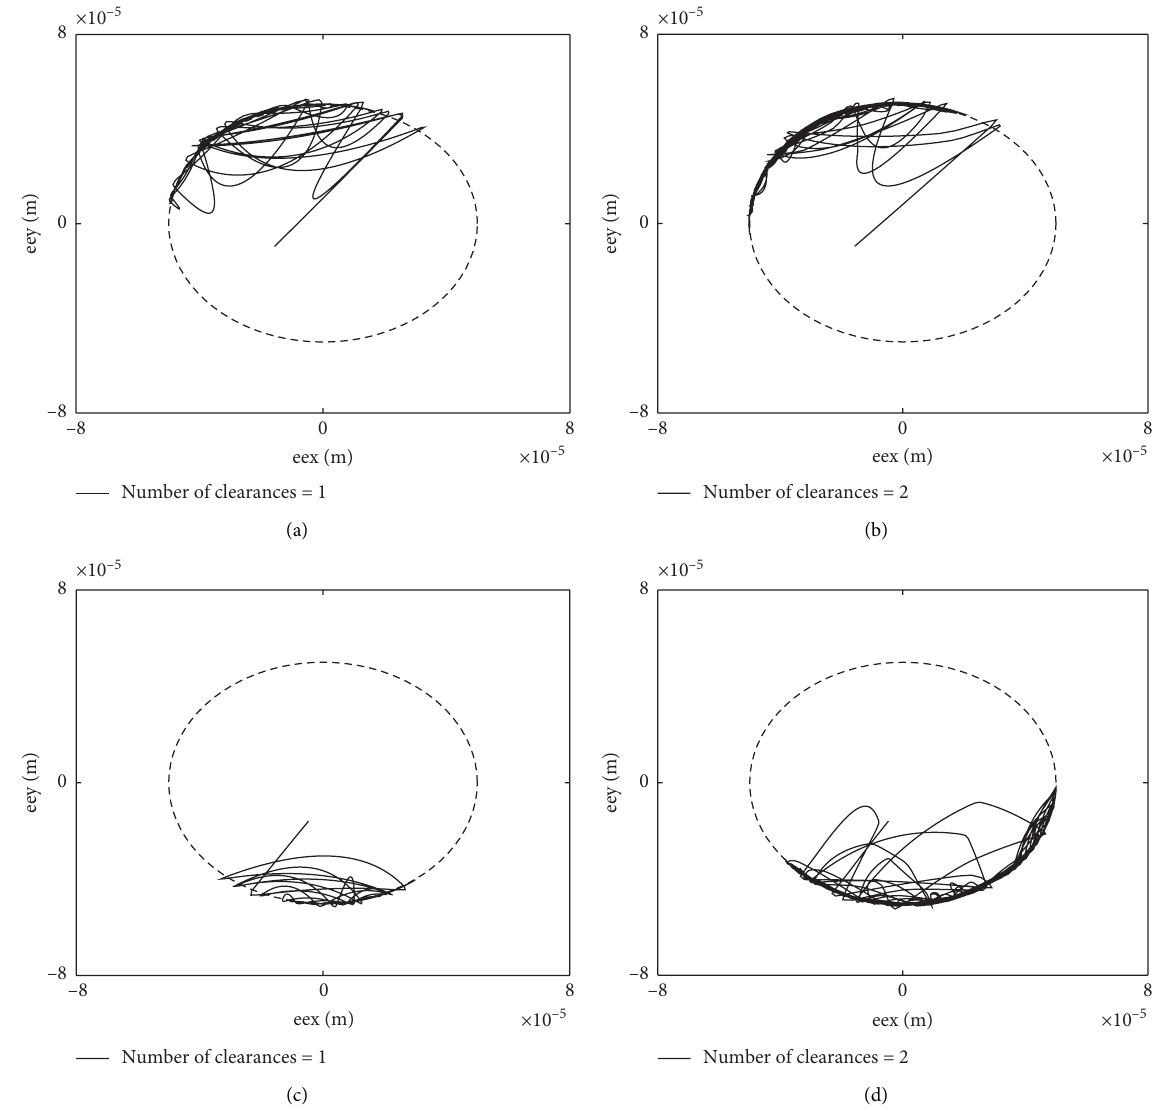
Figure 13: Shaft center motion trajectory at (a) clearance A when the number of clearances is 1, (b) clearance A when the number of clearances is 2, (c) clearance C when the number of clearances is 1, and (d) clearance C when the number of clearances is